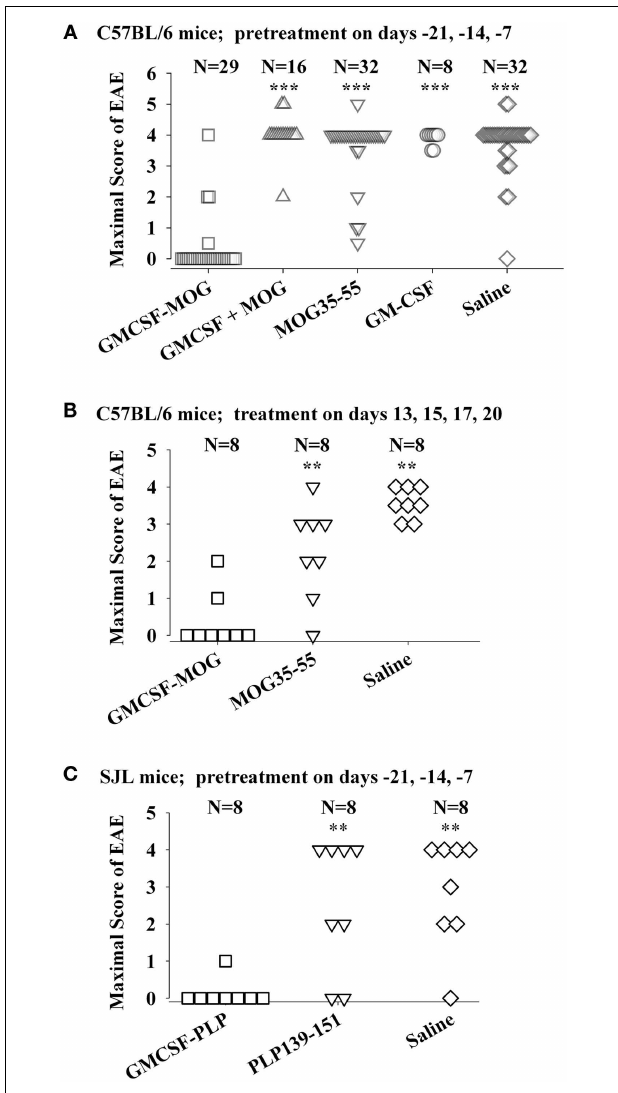
FIGURE 2 | Mouse cytokine-NAg vaccines were effective tolerogens in the C57BL/6 and SJL mouse models of EAE. EAE was elicited in C57BL/6 mice by injection of MOG35–55 in CFA together with separate injections (200ng i.p.) of Pertussis toxin on days 0 and 2. EAE was elicited in SJL mice by injection of PLP139–151 in CFA. EAE induction was on day 0 relative to pre-treatment with designated cytokine-NAg fusion protein or control proteins ( x -axis) on days-21, -14, and -7 (A,C) or treatment on days 13, 15, 17, and 20 (B) .Vaccines were administered subcutaneously in saline. Maximal disease scores were defined as the most severe disease score exhibited by a mouse throughout the relevant disease course.The mouse clinical EAE scoring scale was: 0, no disease; 1.0, partial or full paralysis of the tail or ataxia but not both; 2.0, flaccid paralysis of the tail and ataxia or impaired righting reflex; 3.0, partial hind-limb paralysis; 4.0, full hind-limb paralysis; 5.0 total hind-limb paralysis with forelimb involvement. p Values were calculated by non-parametric ANOVA based on ranked data with a Bonferroni Post hoc Test. Data analysis for these experiments was previously reported in (Abbott et al., 2011). Pre-treatment of C57BL/6 mice was portrayed in Tables 1 and 2 , pre-treatment of SJL mice was portrayed in Table 3 , and treatment of C57BL/6 mice was portrayed inTable 4 of Abbott et al., 2011; *** p ≤ 0.001; ** p ≤ 0.01; * p ≤ 0.05; for comparisons of the cytokine-NAg-treated group with the respective control